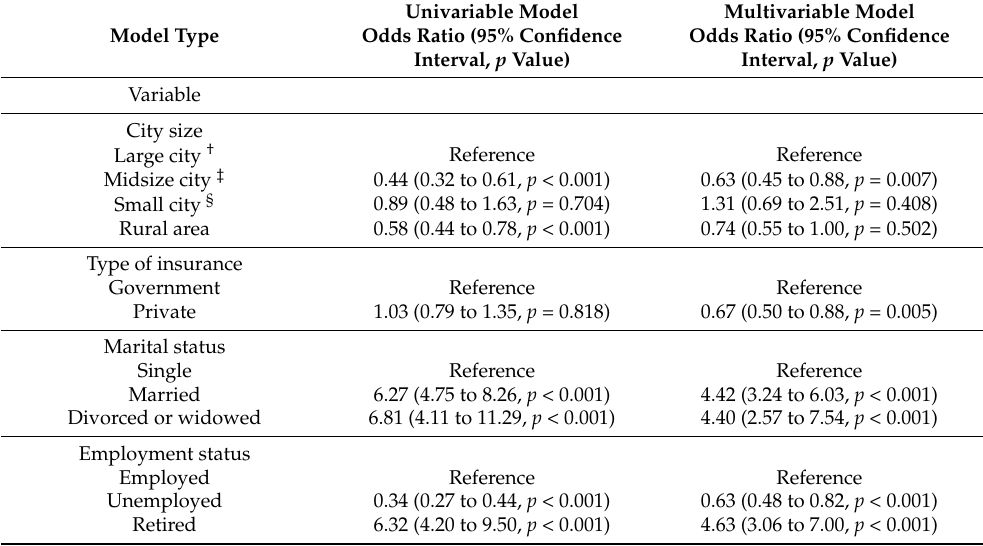
Table 2. Univariable and multivariable logistic regression models to explain high ARABRISK score among the surveyed sample.